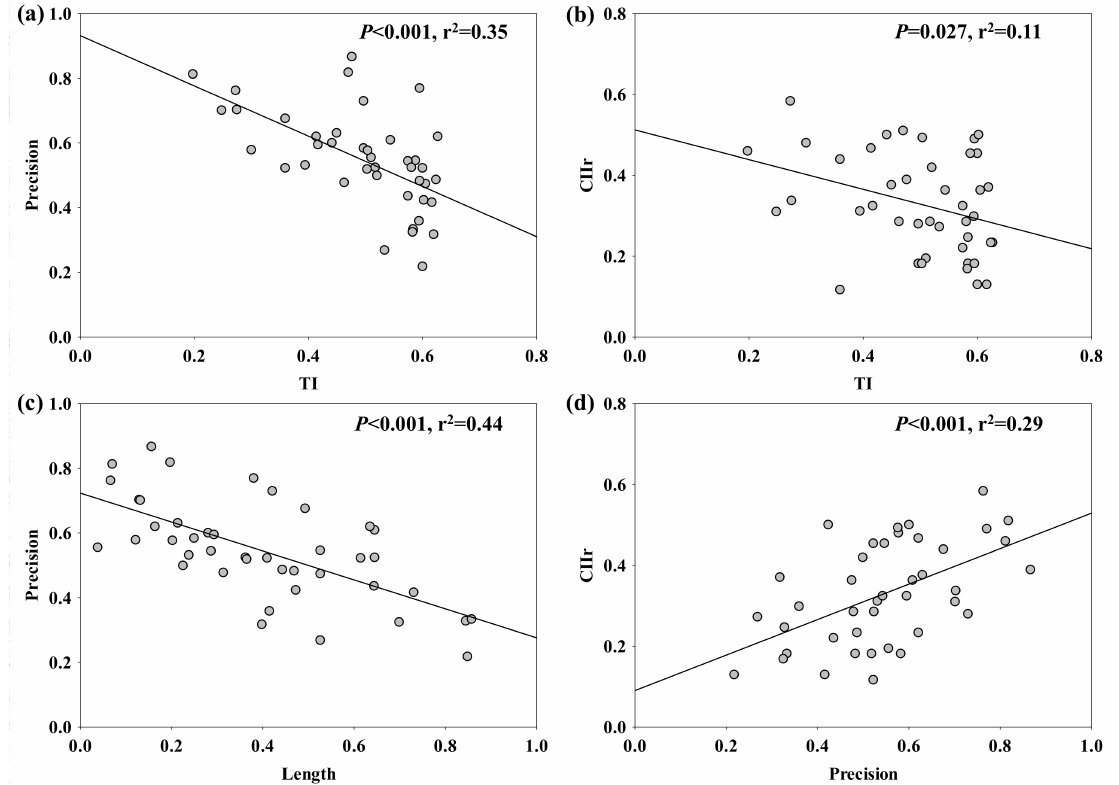
Figure 4. The relationship between barnyardgrass root foraging precision and topological index ( a ) and root length ( c ), between competition intensity index (CII r ) and TI ( b ) and root foraging precision ( d ). Significant ( p < 0.05) linear regression lines are shown with the r-square